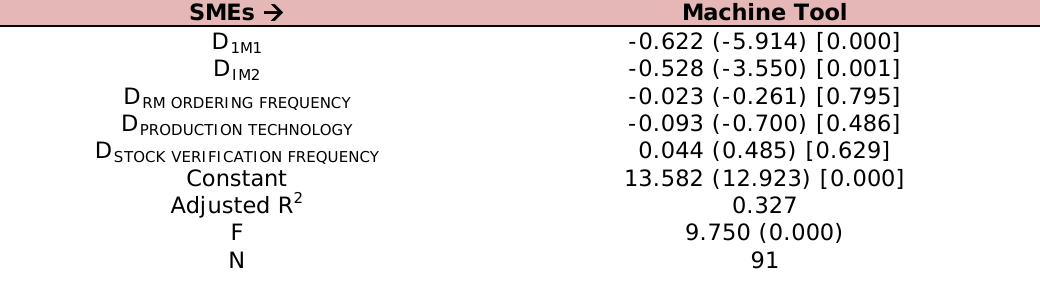
Table 7. “Regression Analysis of Inventory Cost per Sale with IM Type, RM Ordering Frequency, Production Type and Stock Verification Frequency (Dependent Variable: Inventory Cost per